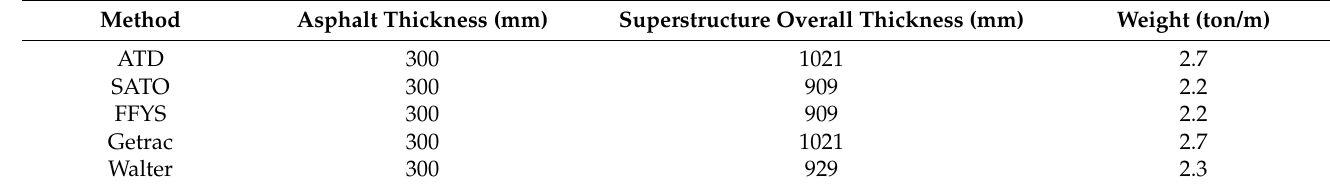
Table 3. Specifications of asphalt bases in ballastless systems